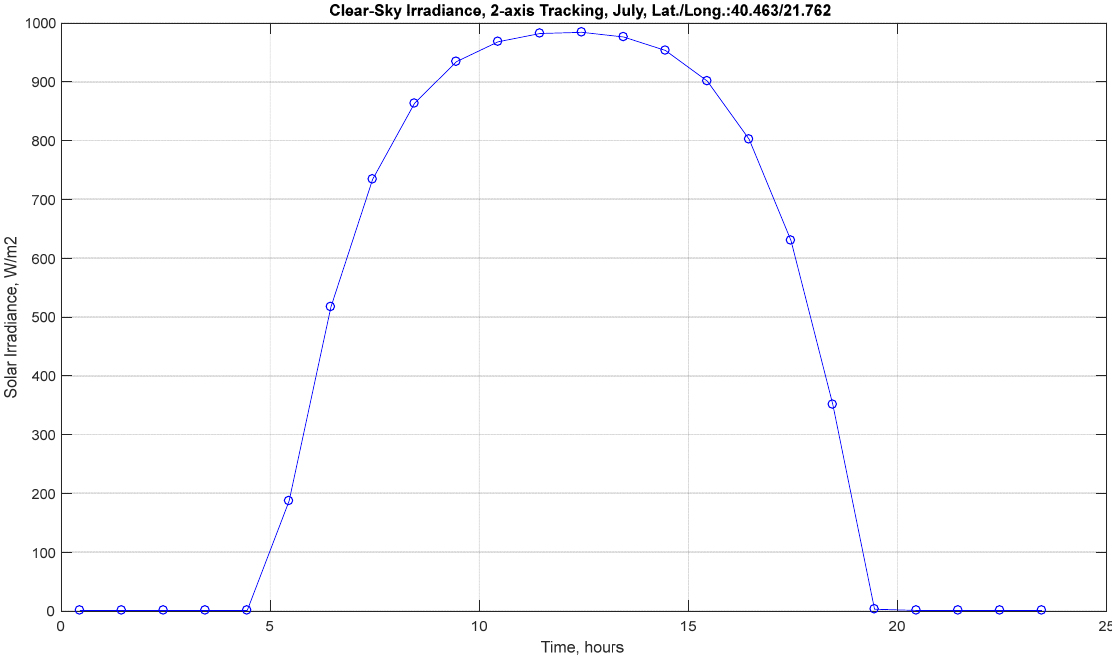
Figure 1. Solar Clear-sky irradiance, on a 2-axis tracking plane, in the month of July, at Ptolemaida, NW Greece, latitude/longitude: 40.463/21.762, during 24 h.